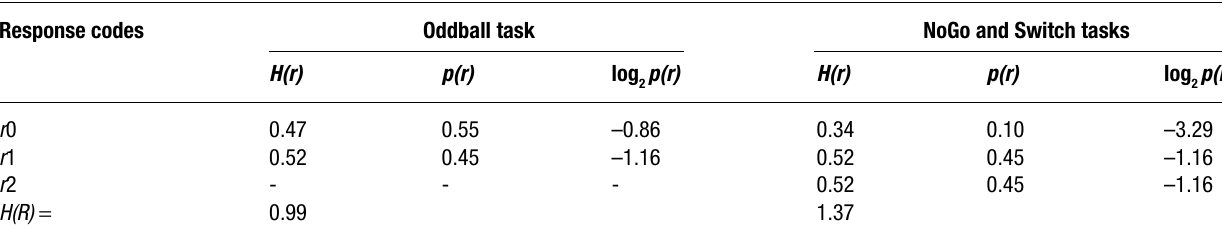
Table A2. Response entropy H R